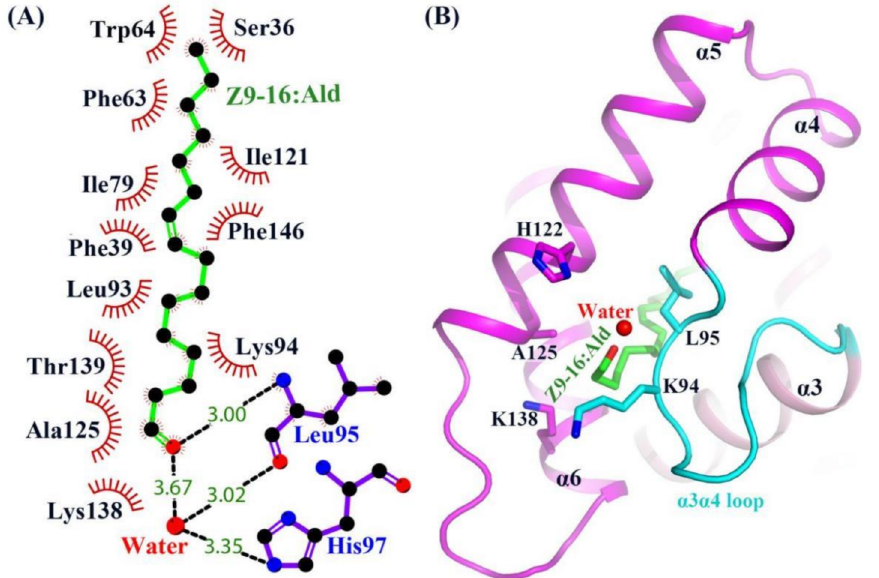
Figure 4. Structure of the Z 9-16:Ald bound state of HarmPBP1. ( A ) LIGPLOT diagram [15] of Z 9-16:Ald. Hydrogen bonds are represented by dashed lines and hydrophobic contacts by arcs with radiating spokes. Atoms involved in hydrophobic contacts are represented by black circles. ( B ) Ribbon diagram of HarmPBP1. A single Z 9-16:Ald molecule (green) binds in the central cavity and enters through an opening formed by α 5, α 6, and the α 3 α 4